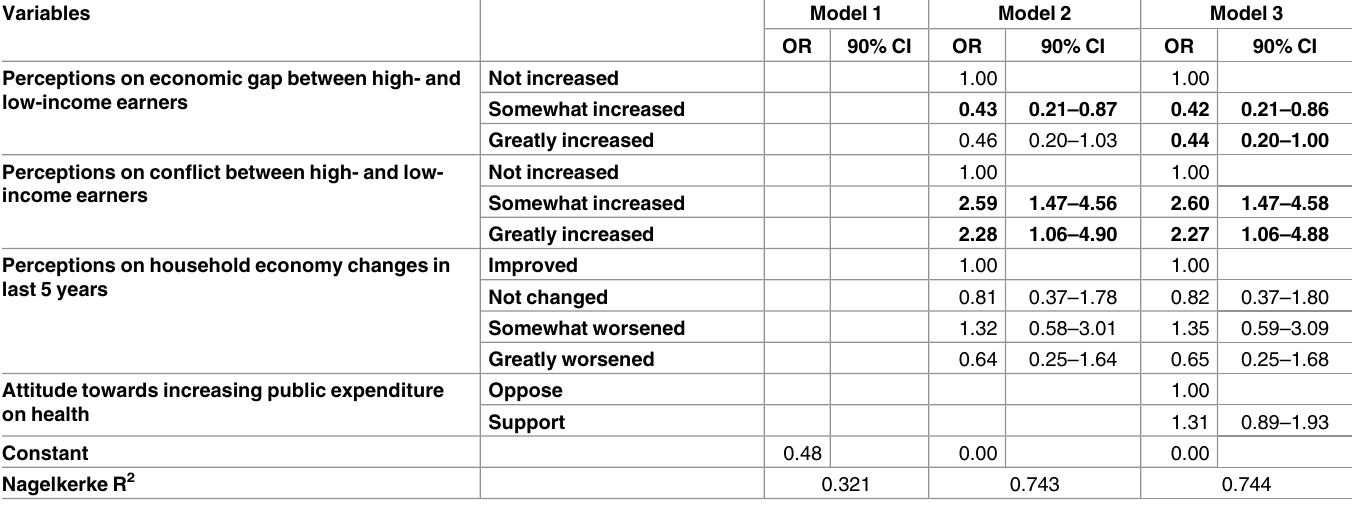
(Table 4). In sum, our findings show that the issue had no meaningful influence on voter’s choice of presidential